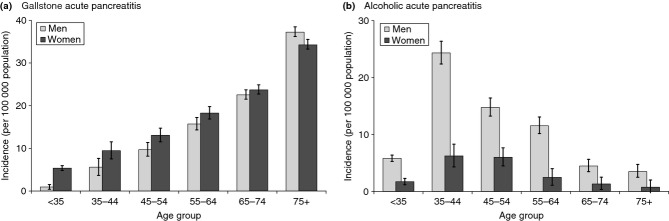
Incidence of acute pancreatitis (per 100 000 population) for men and women in different age groups for gallstone and alcohol aetiologies, in Wales from 1999 to 2010. (a) Gallstone acute pancreatitis. (b) Alcoholic acute pancreatitis. Vertical bars represent 95% confidence intervals.